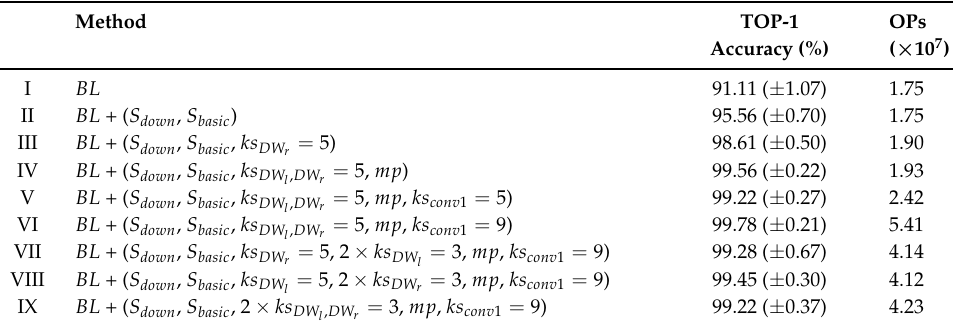
Table 6. Ablation study on NEU.